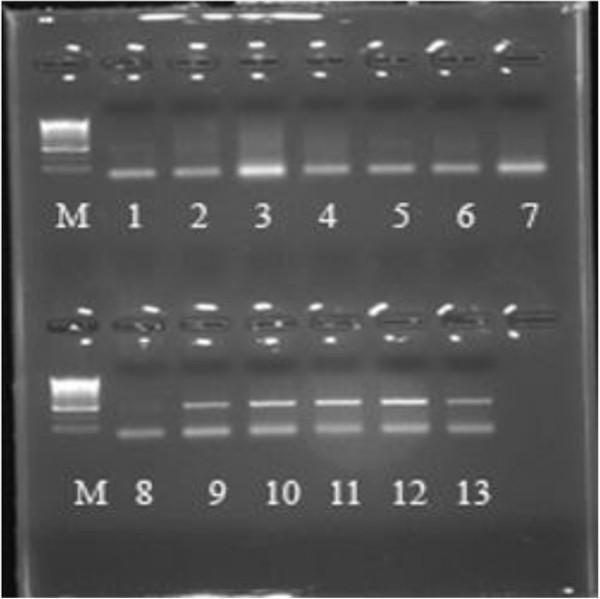
PCR products were analyzed on a 2% agarose gel stained with ethidium bromide and visualized by UV-trans-illumination. Lane M is 50 PCR marker (Promega), Lanes 1, 5 and 8 are weak positive sample, lanes 2, 3, 4, 6 and 7 are negative samples, from lane 9-12 are positive samples and lane 13 is positive control.